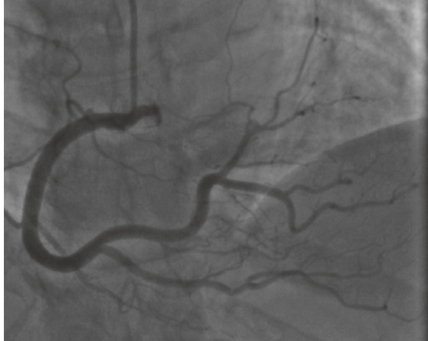
Figure 3: AP cranial view showing dominant RCA supplying LCX territory.